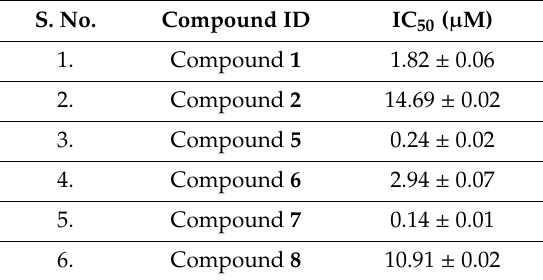
( E ) ( F ) Figure 7. Inhibition of ATPase activity of SphK1. The amount of phosphate released from the hydrolysis of ATP was measured using the standard phosphate curve. Dose-response curve depicting the effect of increasing concentrations of ( A ) Compounds 5 and 7 (0–5 μM), ( B ) Compounds 1 and 6 (0–15 μM), and ( C ) Compounds 8 and 2 (0–30 μM) on the ATPase activity of SphK1. Plots ( D to F ) represent percent inhibition in ATPase activity of SphK1 as a function of increasing concentrations of ( D ) Compounds 5 and 7 , ( E ) Compounds 1 and 6 , and ( F ) Compounds 8 and 2 . The IC 50 value was calculated by fitting the curve obtained from two independent experiments. Table 3. IC 50 values of the selected compounds for SphK1 inhibition calculated from the ATPase inhibition assay.